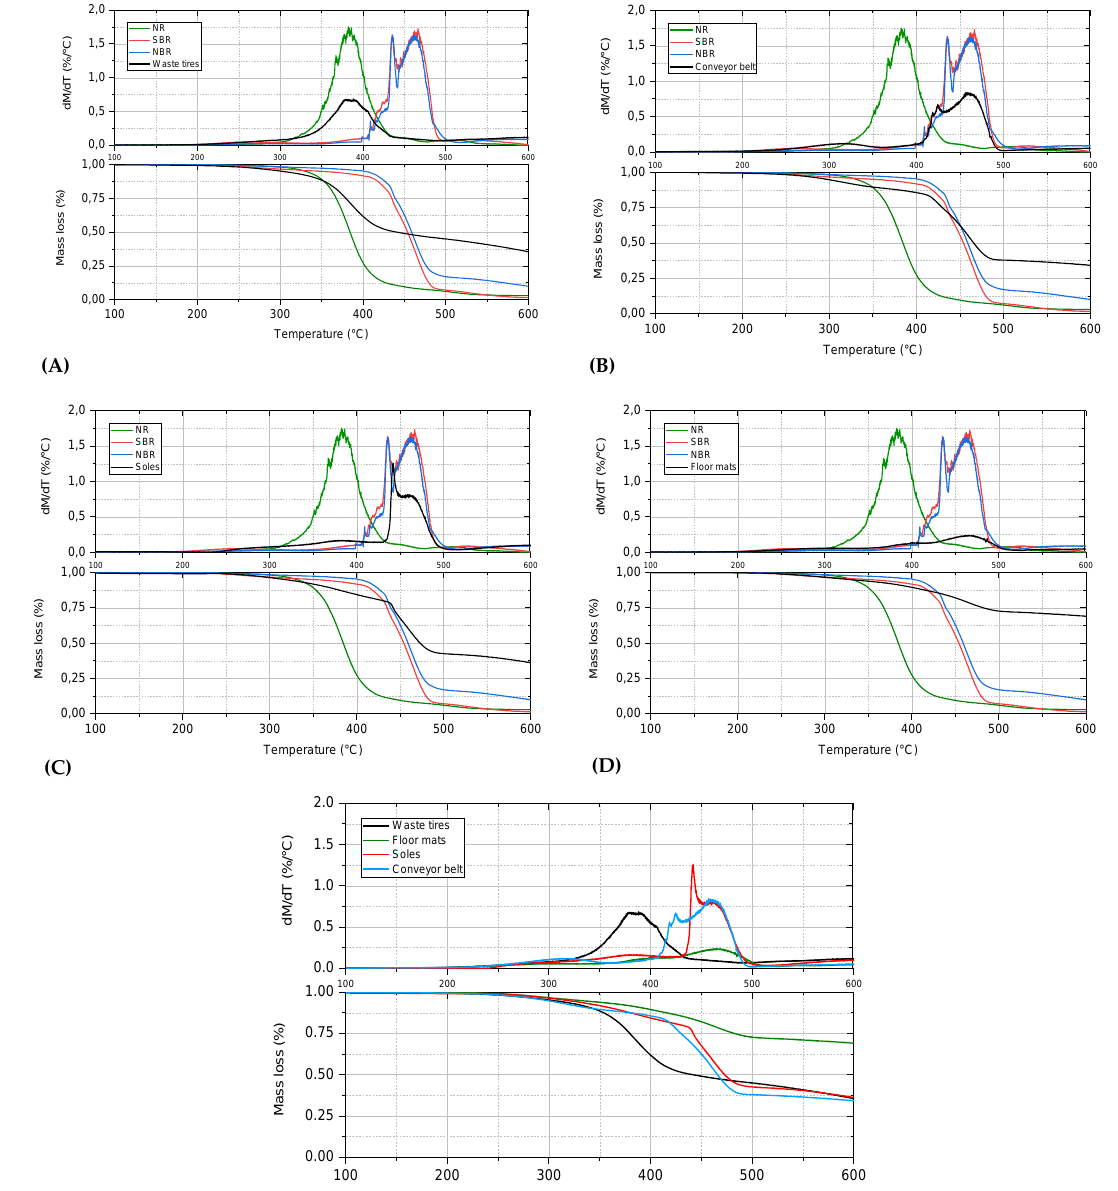
Figure 4. Thermogravimetric analysis (TGA) of ( A ) waste tires; ( B ) conveyor belts; ( C ) soles; ( D ) floor mats; compared with NR, NBR, and SBR degradation, and ( E ) comparison of all rubber waste.